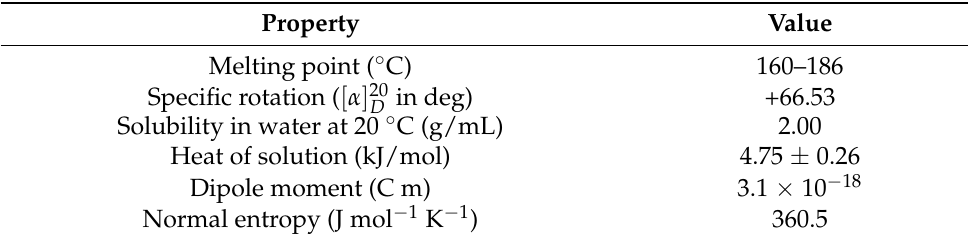
Table 1. Some of the physical properties of sucrose. Table adapted from